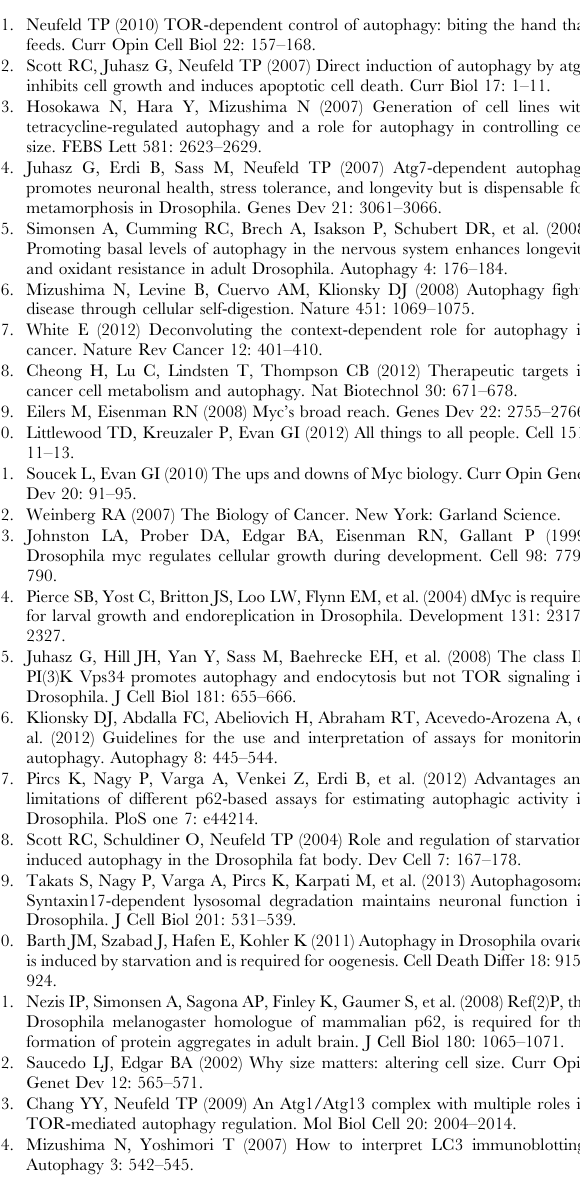
Figure S6 PERK signaling is largely dispensable for cell growth. (A) The unfolded protein response (UPR) reporter XBP1-GFP shows only diffuse fluorescnce in control wing discs that express mCherry-Atg8a in the patched domain. (B) Xbp1-GFP expression is enhanced by overexpression of Myc in the mCherry-Atg8a expression area. (C) Depletion of PERK or overexpression of its antagonist Gadd34 in GFP-positive cell clones has no effect on the size of these fat body cells relative to neighboring control cells. n =7 for both genotypes. (D) PERK RNAi or Gadd34 overex- pression only slightly reduces L3–L4 vein distance compared to L4–L5 vein distance in adult wings, n= 12–19 per genotype. Scalebars in A, B equal 20 m m. Statistically significant differences are indicated, ** p , 0.01. (TIF) Table S1 Quantification of experimental data. The number of individual animals quantified (n) is indicated for all genotypes. Note that in mosaic analyses, clone and control cell pairs were